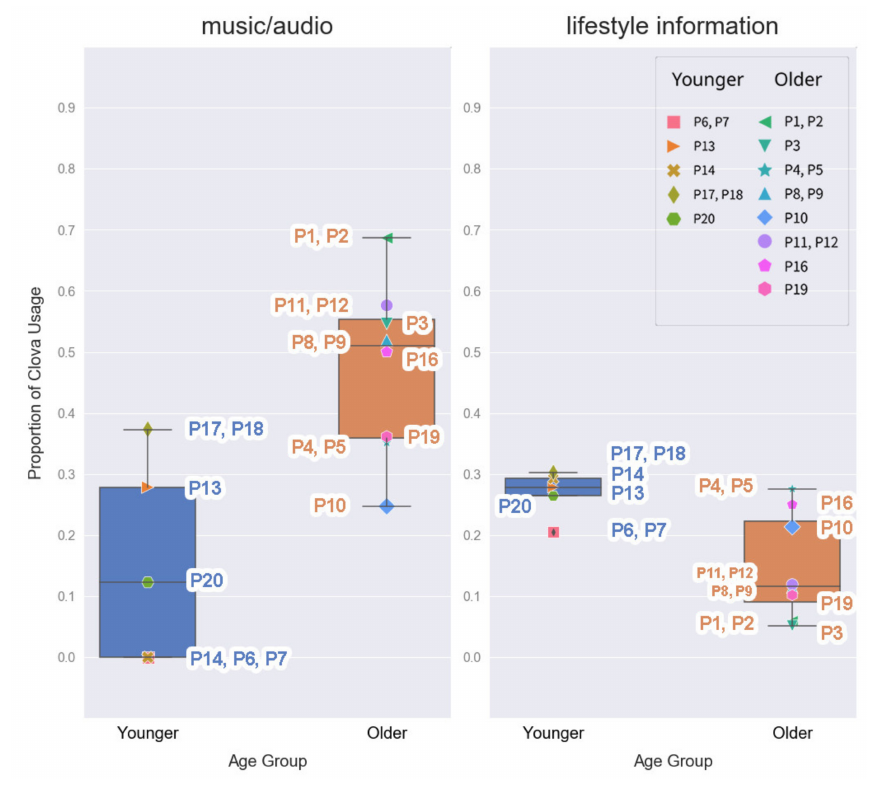
Figure 3. Proportion of Clova usage by age group: music / audio and lifestyle information.